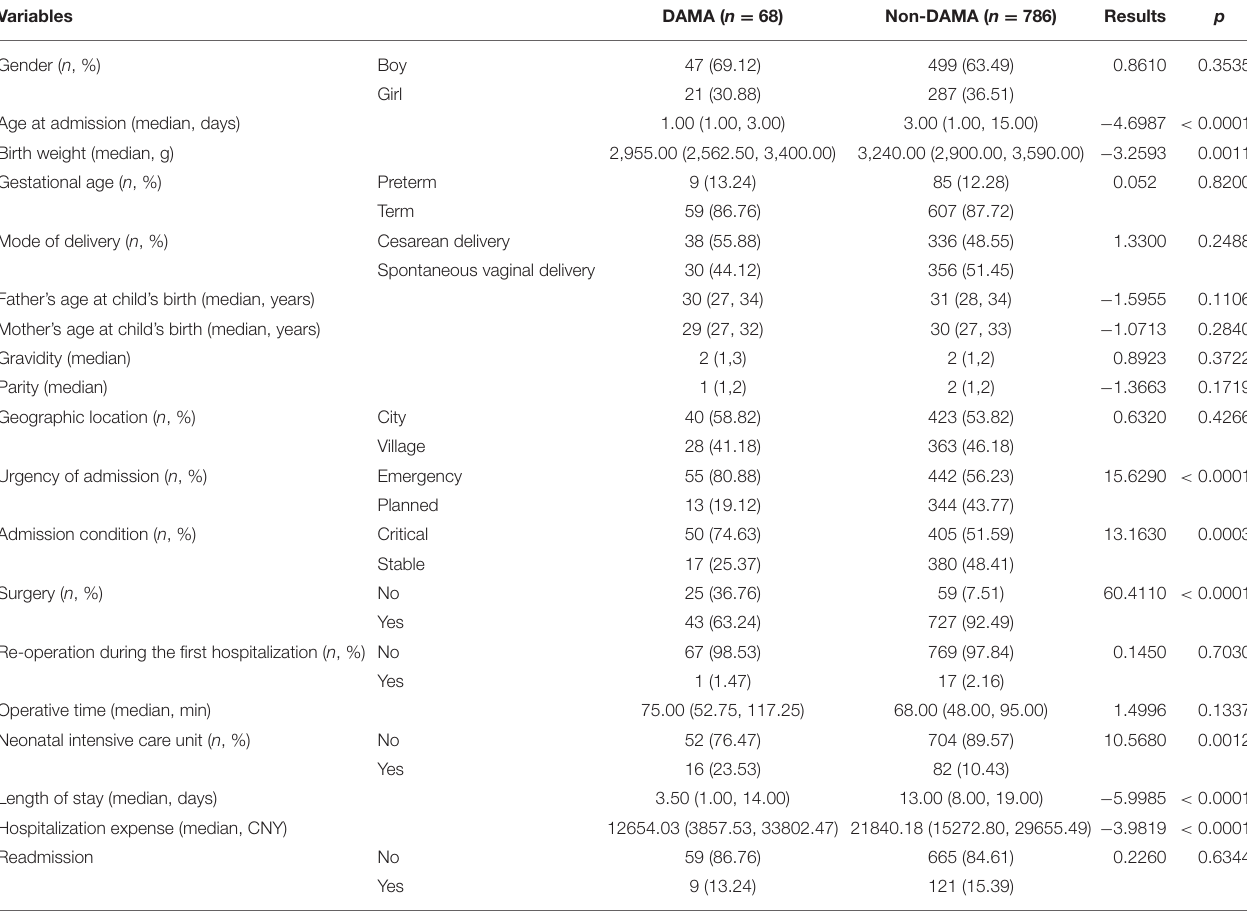
TABLE 1 | Comparison between DAMA and non-DAMA groups. Variables